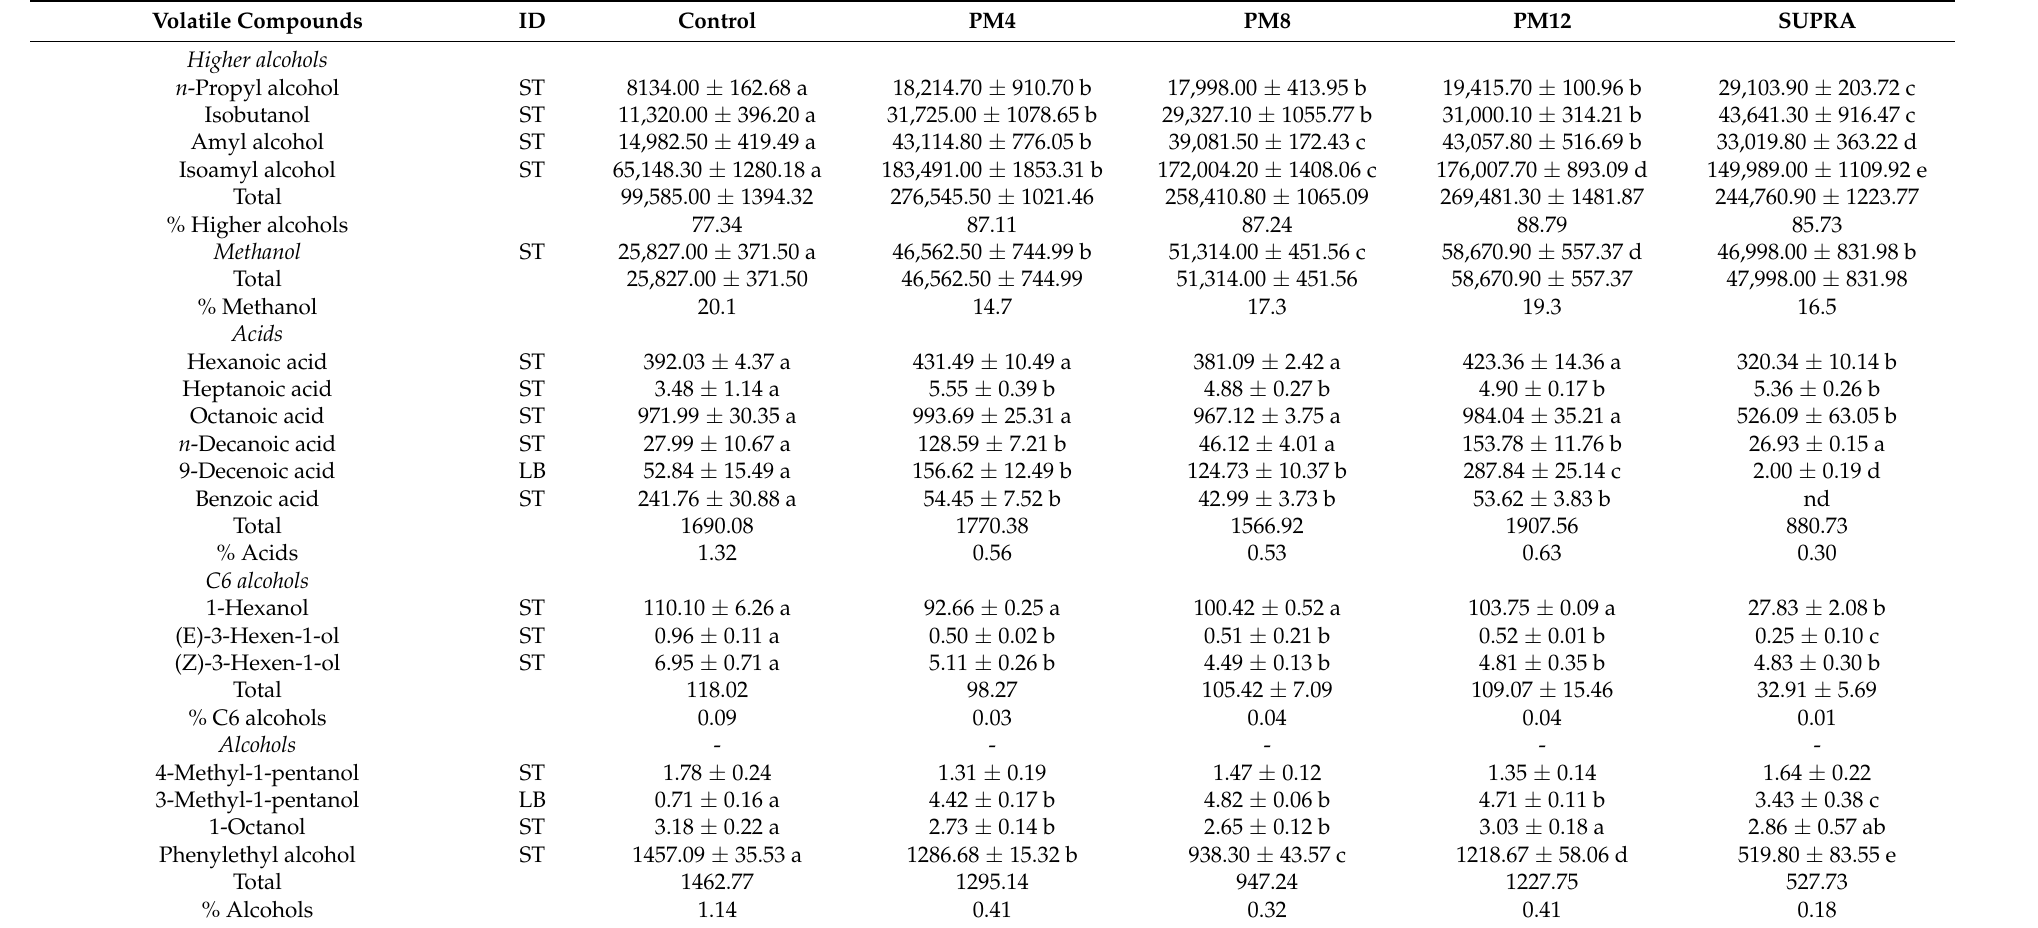
Table 1. Volatile compound concentrations ( µ g/L) of Palomino fino wines made using extractive